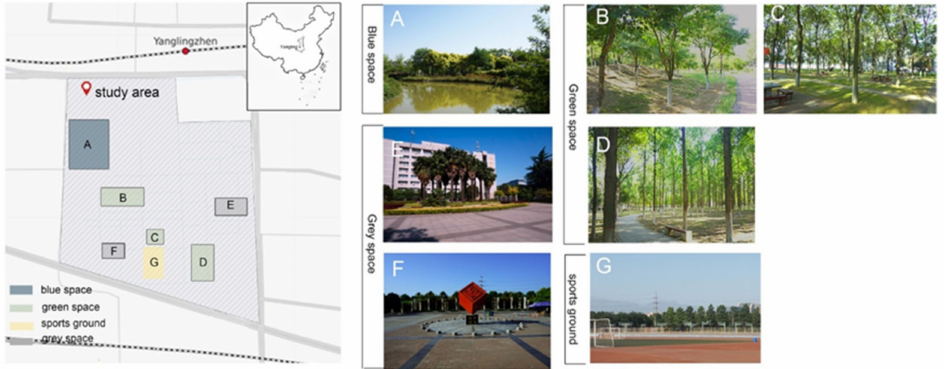
Figure 1. Study area and photographs of the study sites at Northwest A&F University, Shaanxi, China (( A ) represents blue space, ( B – D ) represent green space, ( E , F ) represents grey space, and ( G ) represents sports